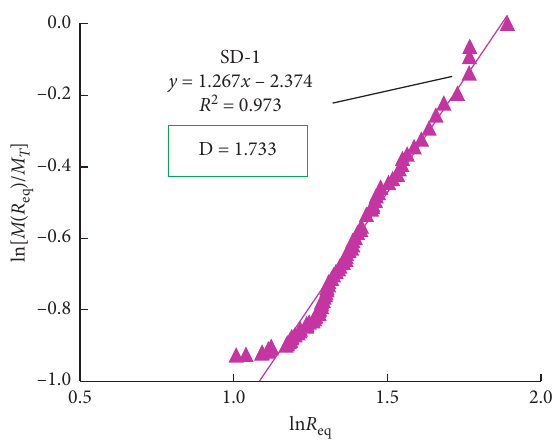
Figure 10: Calculation of fractal dimension of a typical self-ini- tiated rockburst.